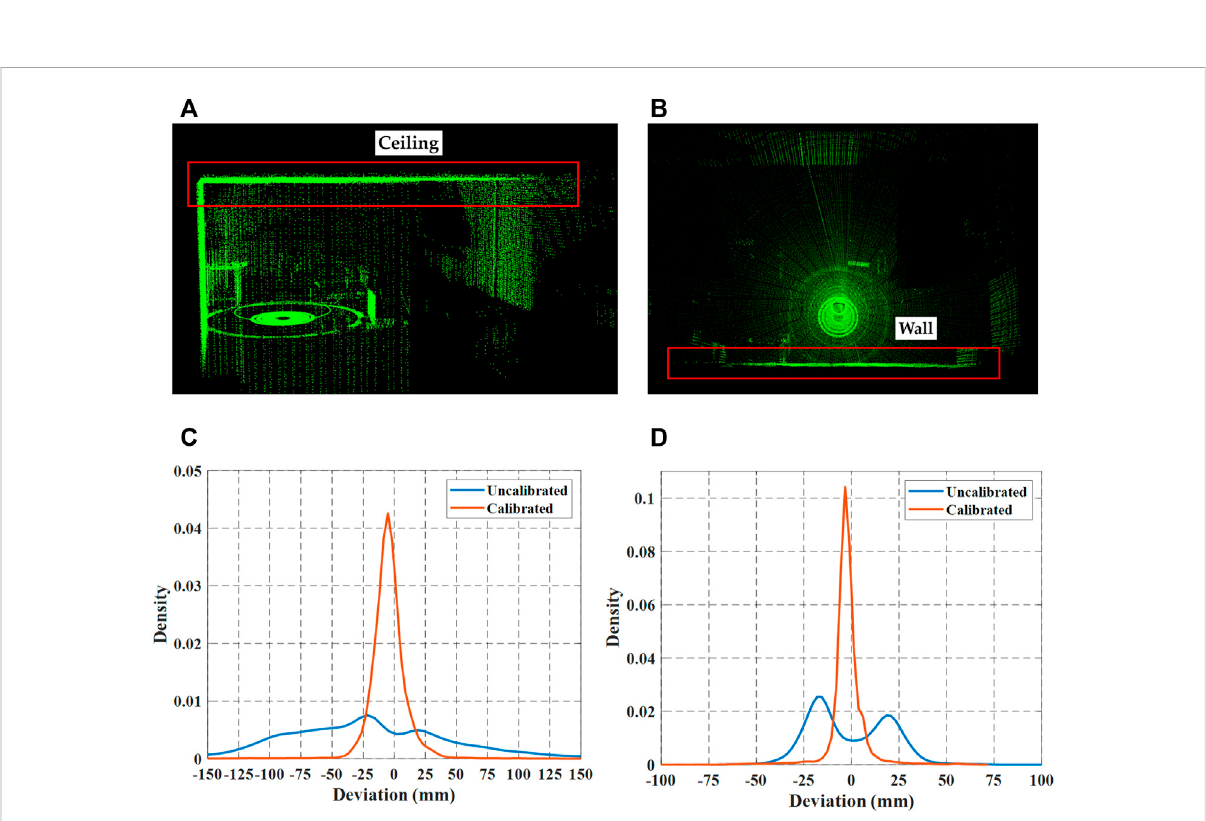
FIGURE 9 Deviationcomparisonoftheuncalibratedplaneandthecalibrated plane,respectively (A) ceilingplane (B) wallplane (C) ceiling plane histogram (D) wall plane